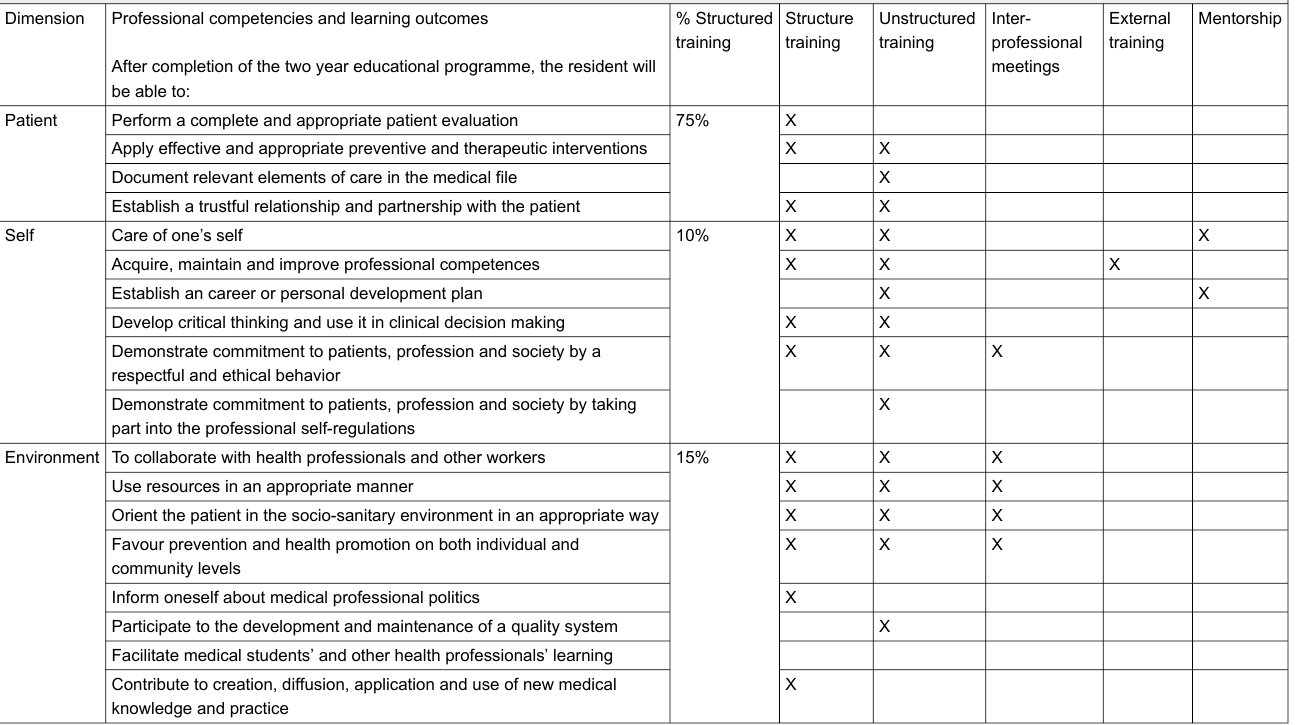
Table 1: List of professional core competencies, resident learning outcomes and training activities of the new curriculum Dimension Professional competencies and learning